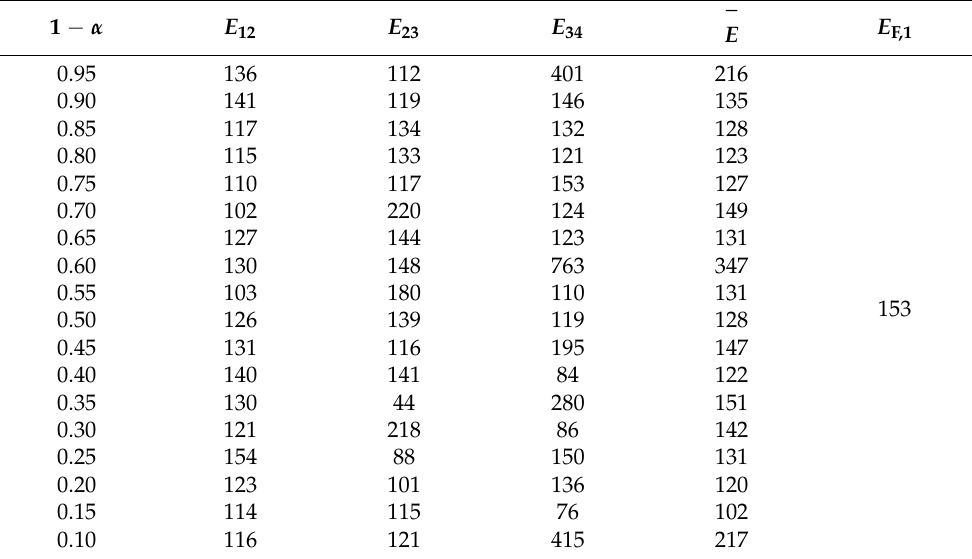
Table 7. The activation energy E F,1 of CYA decomposition from one-interval method (Unit: